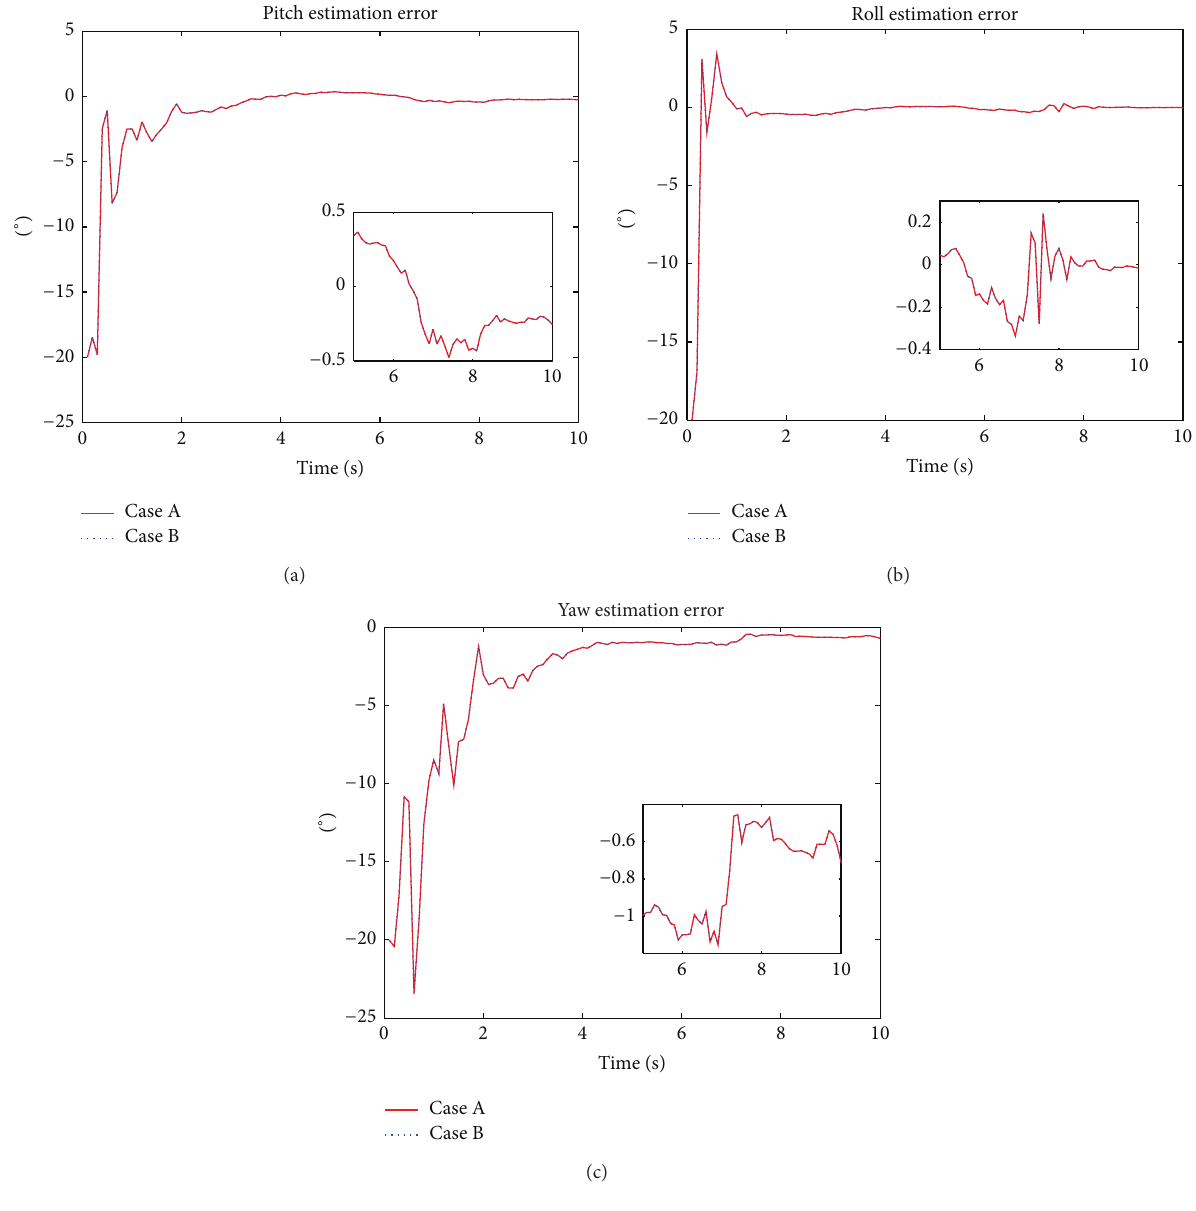
Figure 1: The attitude estimation error of first phase.